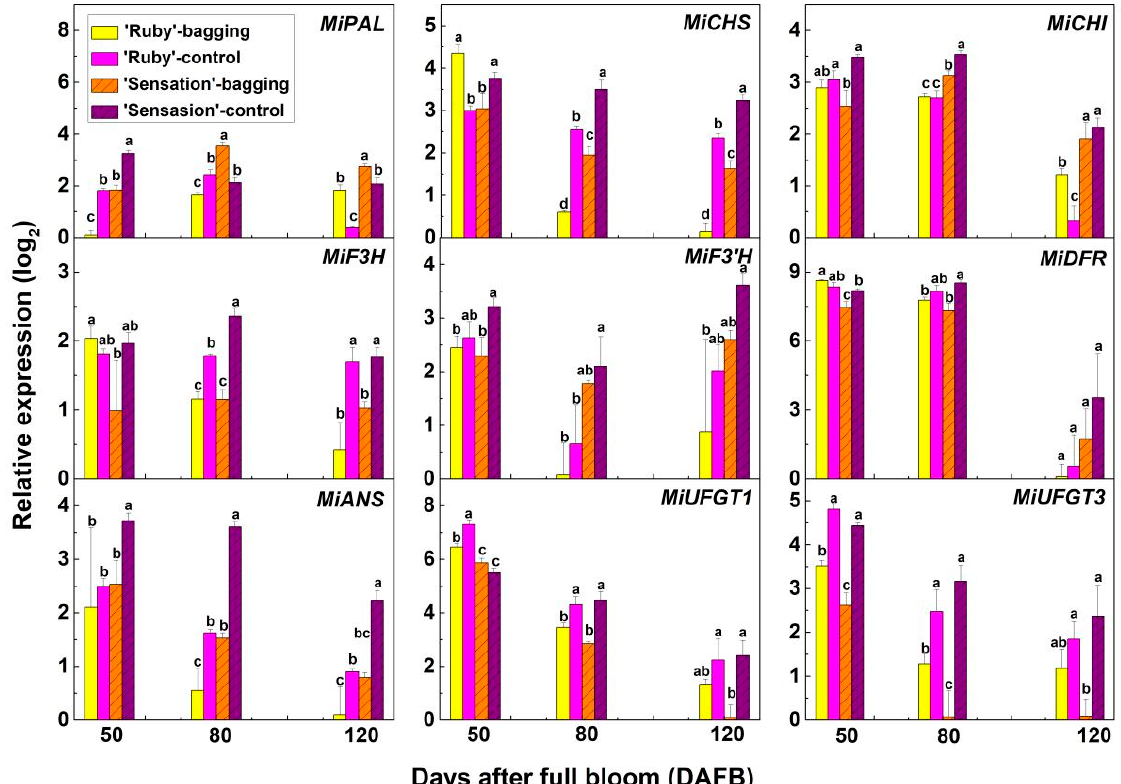
Figure 3. log 2 expression levels of anthocyanin biosynthetic genes in bagged and control (non-bagged) ‘Ruby’ and ‘Sensation’ mango fruit skin at different developmental stages. Each value represents the mean ± standard deviation of three biological replicates. Mean values were compared within the same day after full bloom, and values with the same letter are not significant-ly different, p > 0.05 according to Tukey